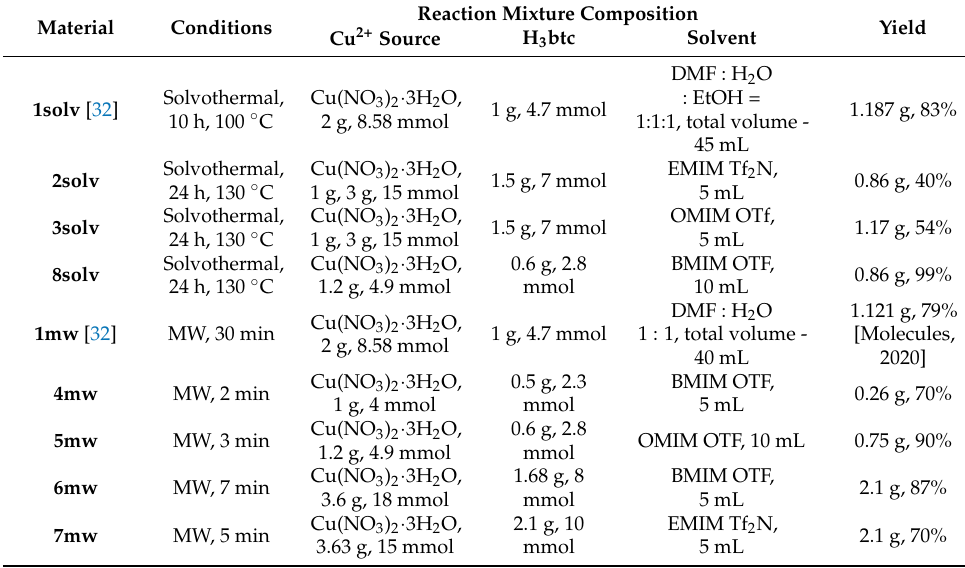
Table 1. Synthesis of the HKUST-1